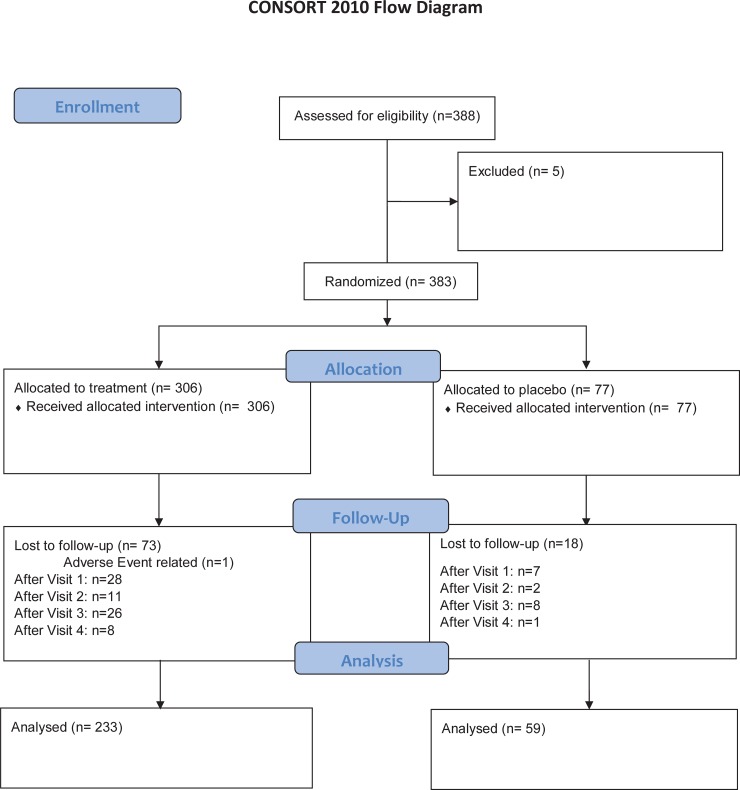
CONSORT patient flow diagram for the finasteride challenge trial.Patients were excluded based on their risk of high grade disease based updated clinical data. PSA measurements were often repeated to be within the 6 month window at time of enrollment. The loss to follow-up subjects included men who withdrew from the study, many of whom decided to postpone their prostate biopsies.